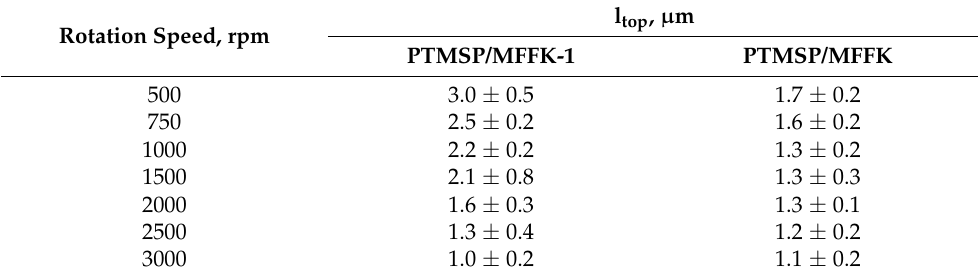
Table 4. Thickness of the outer selective layer (l top ) of composite membrane obtained by applying PTMSP solutions in chloroform (0.35 wt %) on porous supports MFFK-1 and UFFK at different rotation